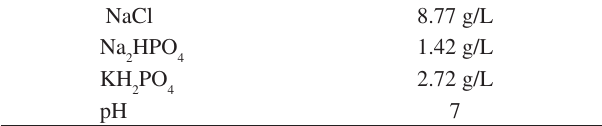
Table 2. Composition of the PBS solution.